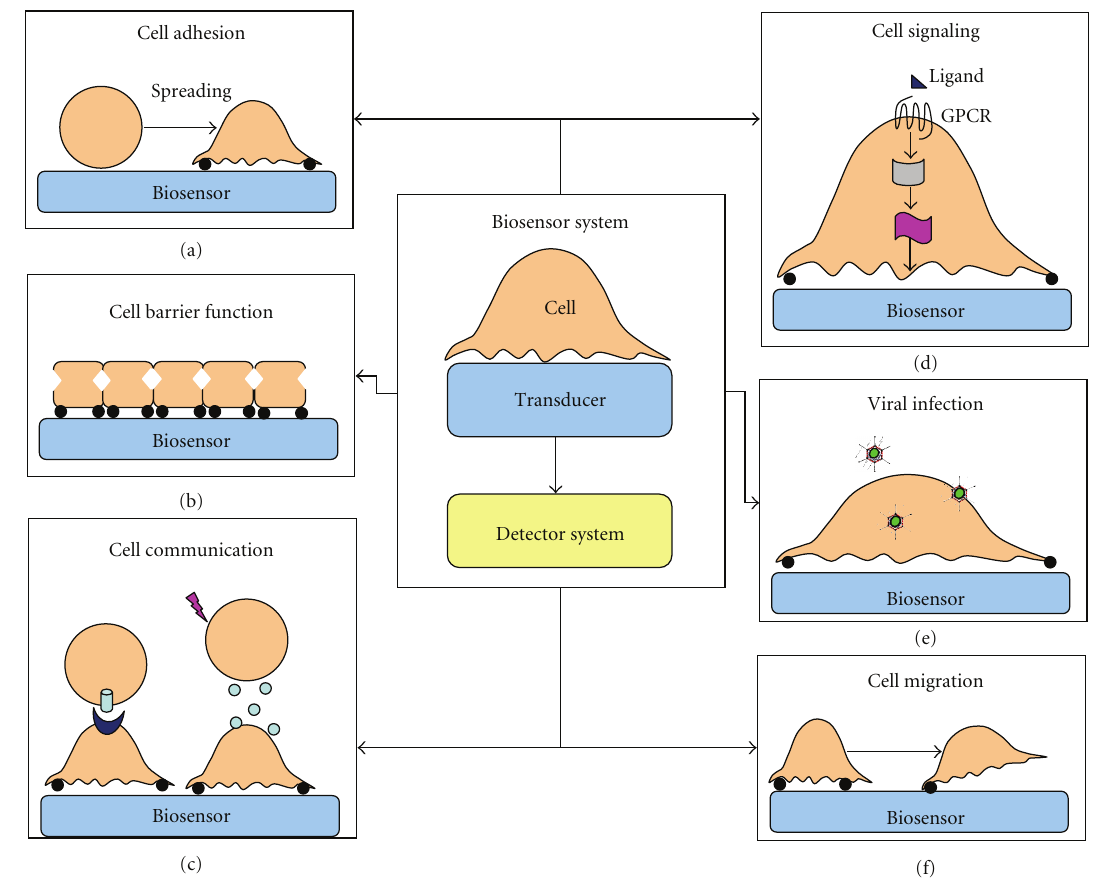
Figure 1: Label-free biosensor and its uses for cell biology. (a) Cell adhesion to a surface; (b) cell barrier functions and regulation; (c) cell- to-cell communication via direct interactions or chemical communication; (d) cell signaling via the receptor activation by an agonist; (e) viral infection; and (f) cell